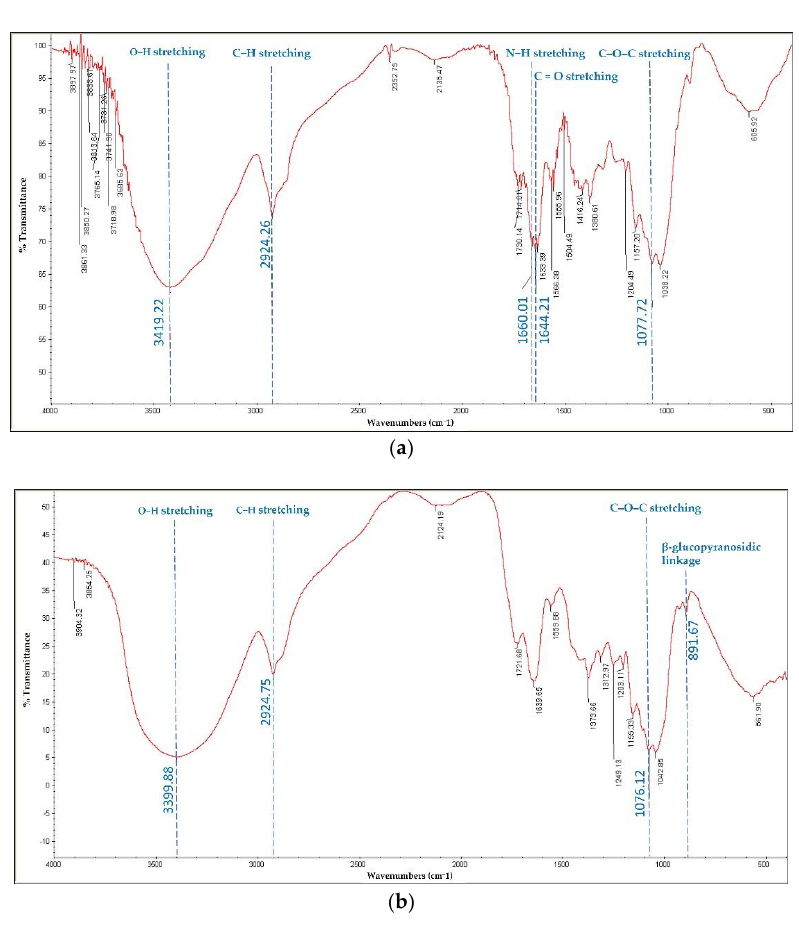
Figure 1. FTIR spectra of commercial BG ( a ); and antler-type G. lucidum BG ( b ). 3.3. Nuclear Magnetic Resonance Spectroscopy (NMR) of Antler-Type G. lucidum BG The 13 C solid-state NMR spectra of G. lucidum BG are depicted in Figure 2 . Figure 2 a shows the spectrum of G. lucidum BG, containing six specific resonance peaks of a linear (1 → 3)- β -D-glucan [37]. The six resonance peaks at 61.9, 68.7, 74.6, 77.7, 86.9 and 104.5 ppm correspond to C6, C4, C2, C5, C3, and C1, respectively. While the resonance peaks at 86.9 ppm correspond to (1 → 3)-linked residues of C3 and show the formation of the β -D- glucan chains in triple helices, the resonance peak at 104.5 ppm is related to the C1 carbon in the β -glycosidic bond. [38]. C4, C2, and C5 signals occur at the chemical shift of 68.7, 74.6 and 77.7 ppm, respectively. Whereas the signals of (1 → 6)-linked C3 and C6 carbons are typically detected. Apart from the signals corresponding to the carbons of (1 → 3, 1 → 6)- β -D-glucan, the significant peaks close to 175 ppm (C = O), 56 ppm (C2), and 23 ppm (CH 3 ) occur, which might specify the presence of chitin [39,40], implying the occurrence of impurities in the commercial BG (Figure 2a). Nevertheless, it should be noted that the chemical shifts for the C atoms of this sample have similar values to NMR spectra of com- mercially available BG (Figure 1b) and BG obtained from Kluyveromyces marxianus [9]. Likewise, it is comparable to well-studied BG [11,41,42]. Based on the above results and information from the literature [11,37,41,42], it was suggested that the main polysac- charide component recovered from the antler-type fruiting bodies of G. lucidum by an